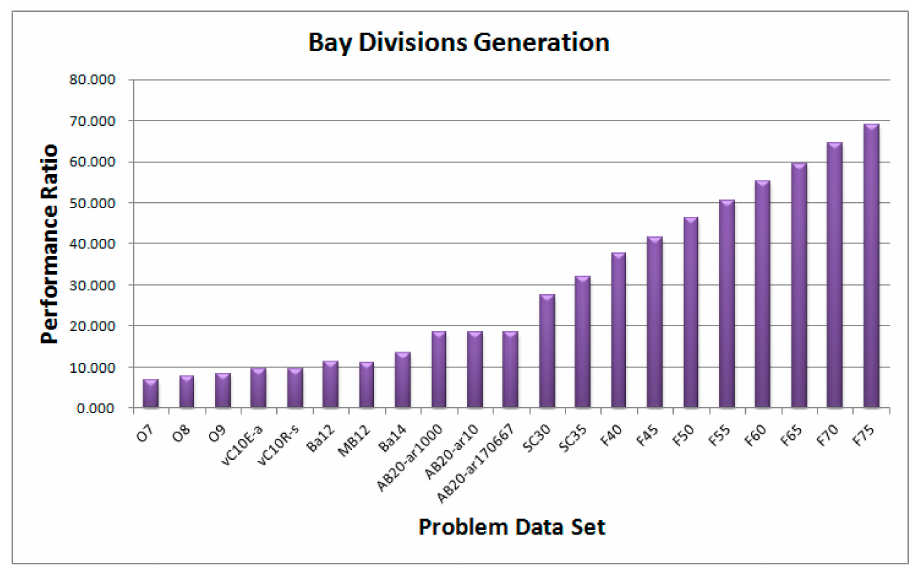
Figure 7. Performance ratio between INI_BD2 and INI_BD1 for generation of bay